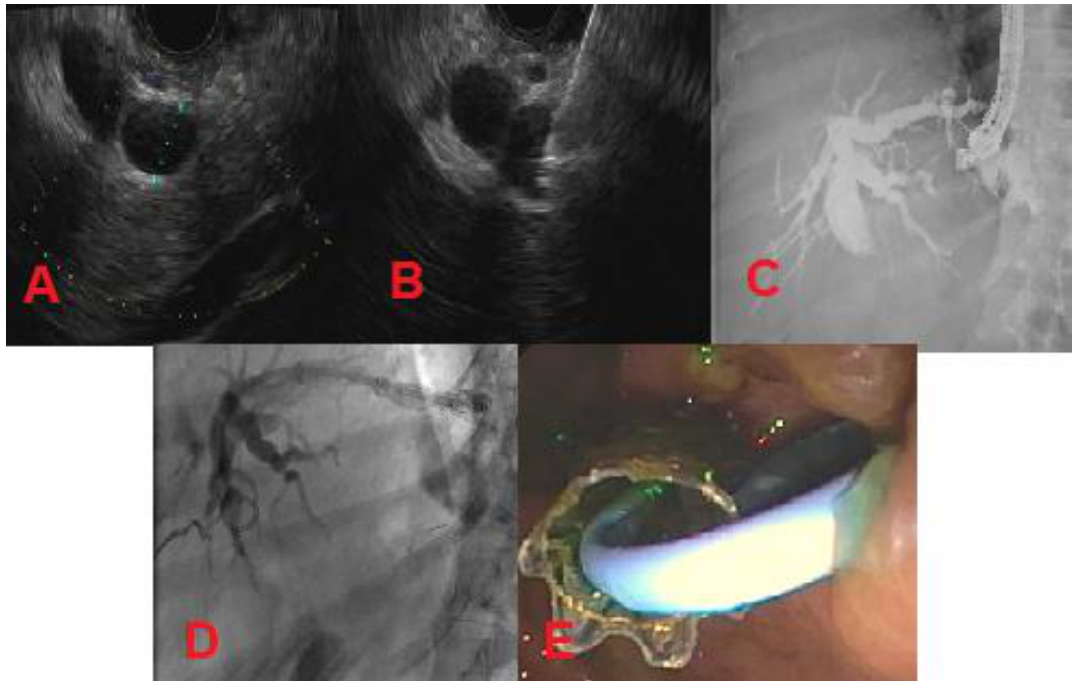
Figure 4. Metastatic pancreatic cancer (patient with history of Roux-en-Y gastric bypass surgery). ( A ) Dilated left intrahepatic biliary radicle; ( B ) Needle puncture of left intrahepatic biliary radicle using a 19-gauge needle; ( C ) Cholangiogram showing dilated intrahepatics, proximal and mid-common bile duct; ( D , E ) Left-sided hepaticogastrostomy.